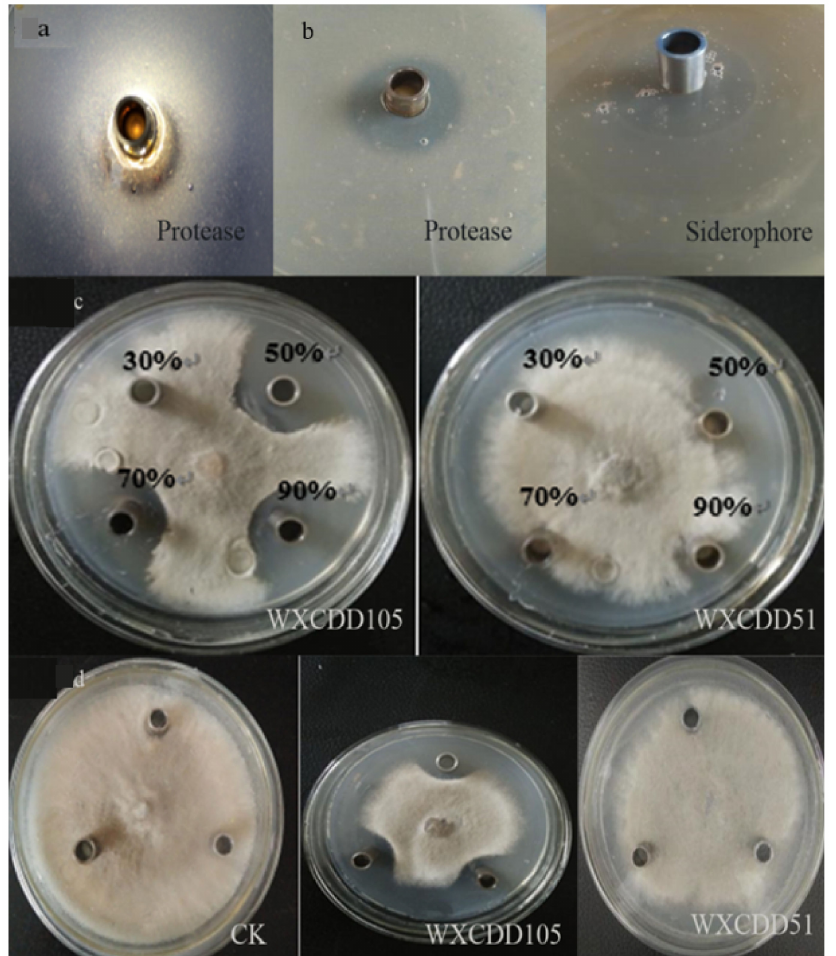
Figure 8. ( a , b ) Detection of secretory substances in strains WXCDD51 and WXCDD105. ( c ) An- tibacterial activity of antibacterial crude protein. ( d ) Determination of antibacterial activity of lipopeptide